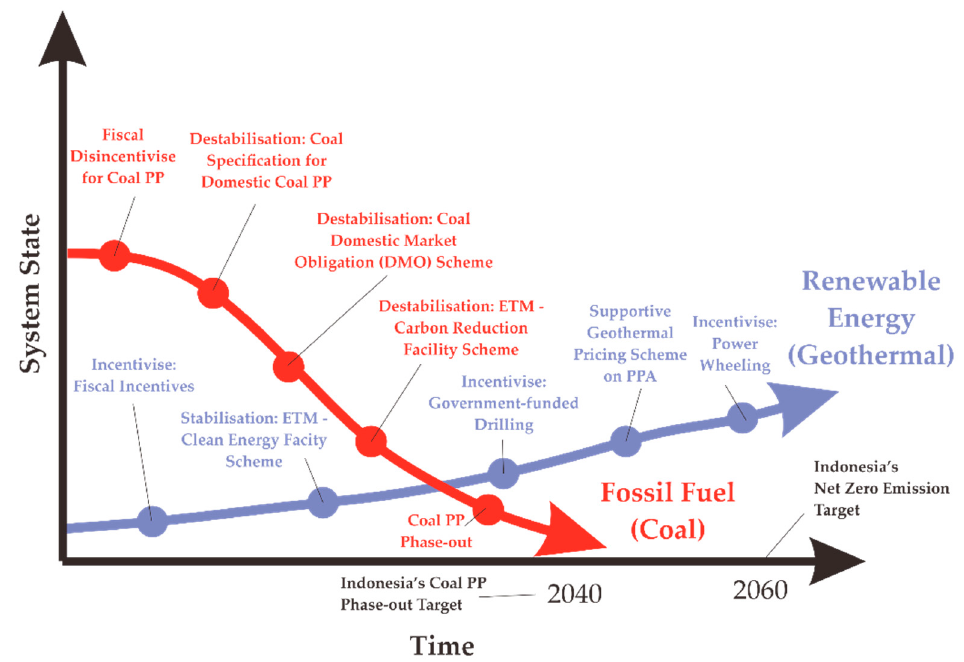
Figure 3. Illustration of the transition pathways of the coal and geothermal energy